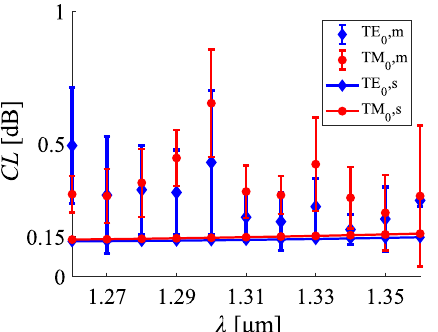
Figure 5. Characterisation data for the fundamental TE and TM modes, along with the simulated values. Coupling loss under varying wavelength along the O-band, when the widths of the two waveguides equal the 2.5 µ m value and the angle is set at 0 ◦ . The index m denotes measurement data, while s corresponds to simulation results. The characterisation data and the error bars refer to the mean value and the standard deviation of the cut-back losses,